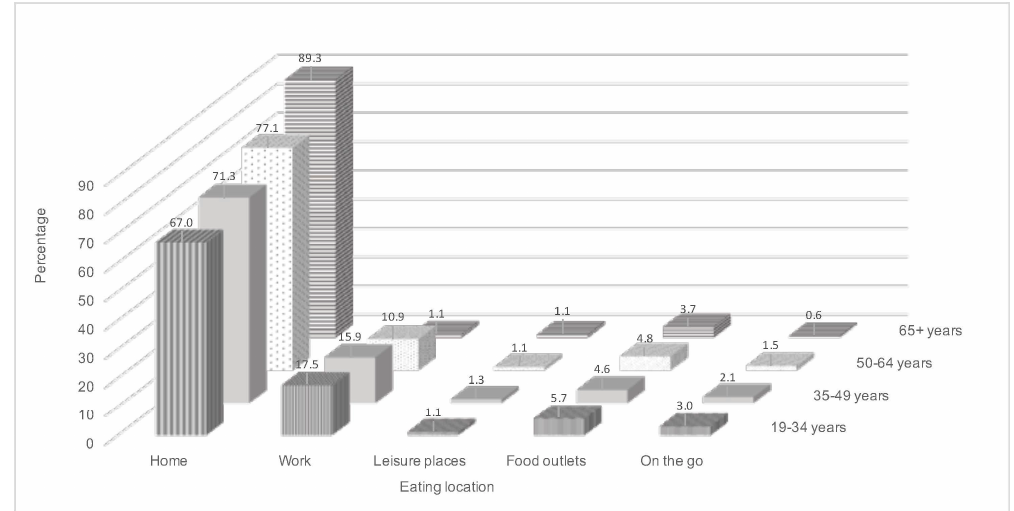
Figure 1. Percentage of reported eating location by age group for the National Diet and